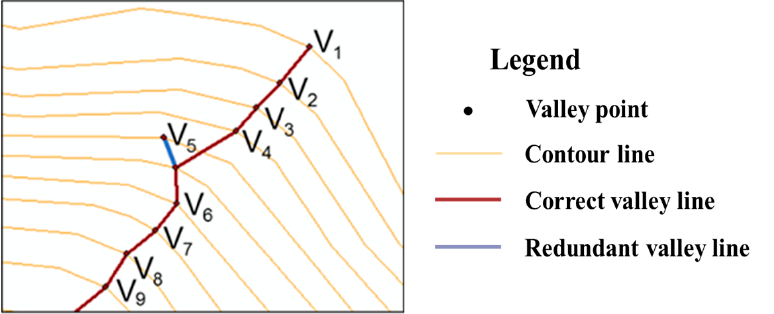
Figure 9. Example of a redundant valley line. V 1 ‒ V 9 are the valley points extracted in previous step.